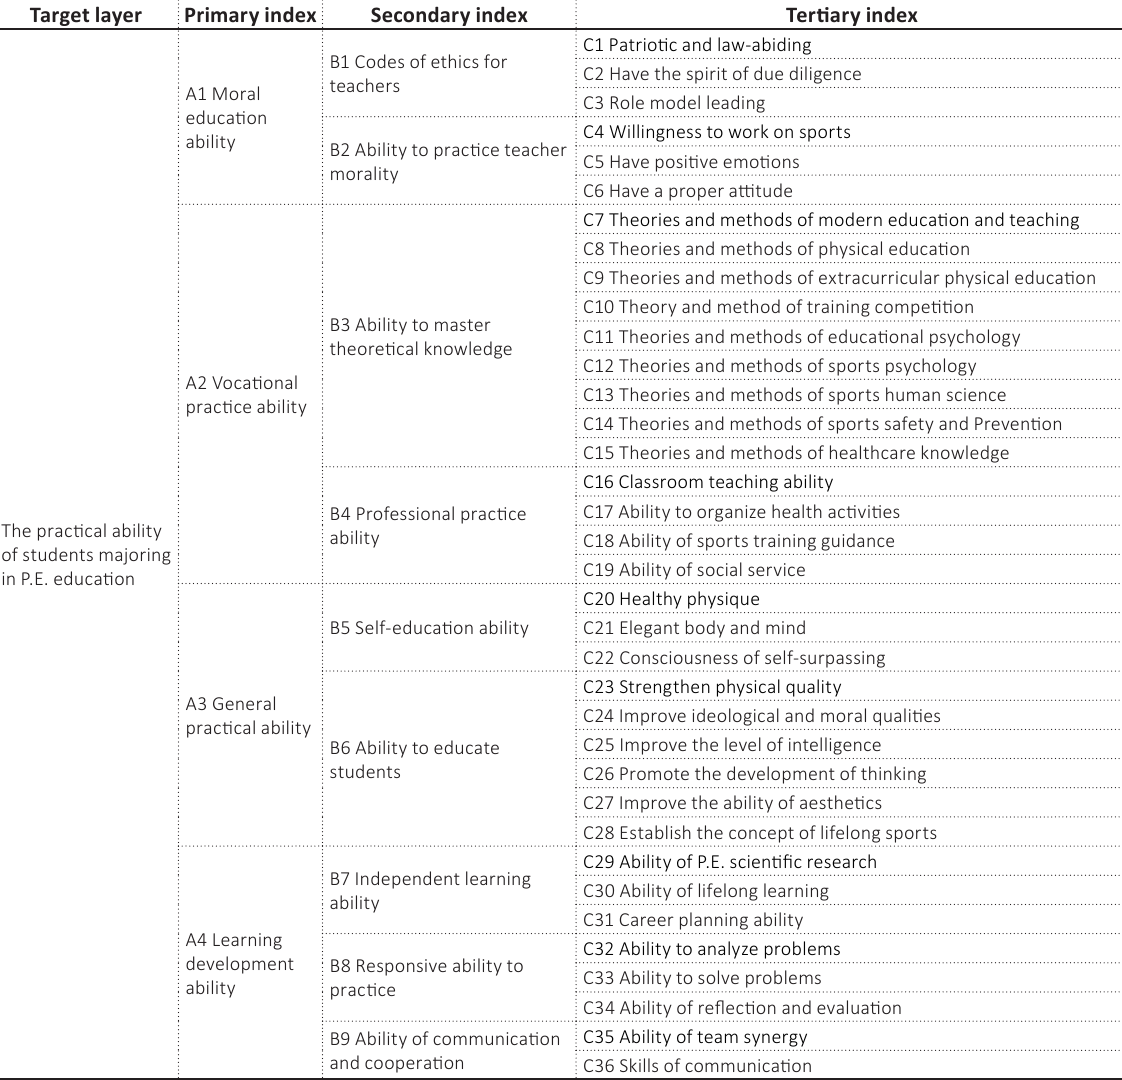
Table 1. Practical ability indexes of students majoring in physical education Target